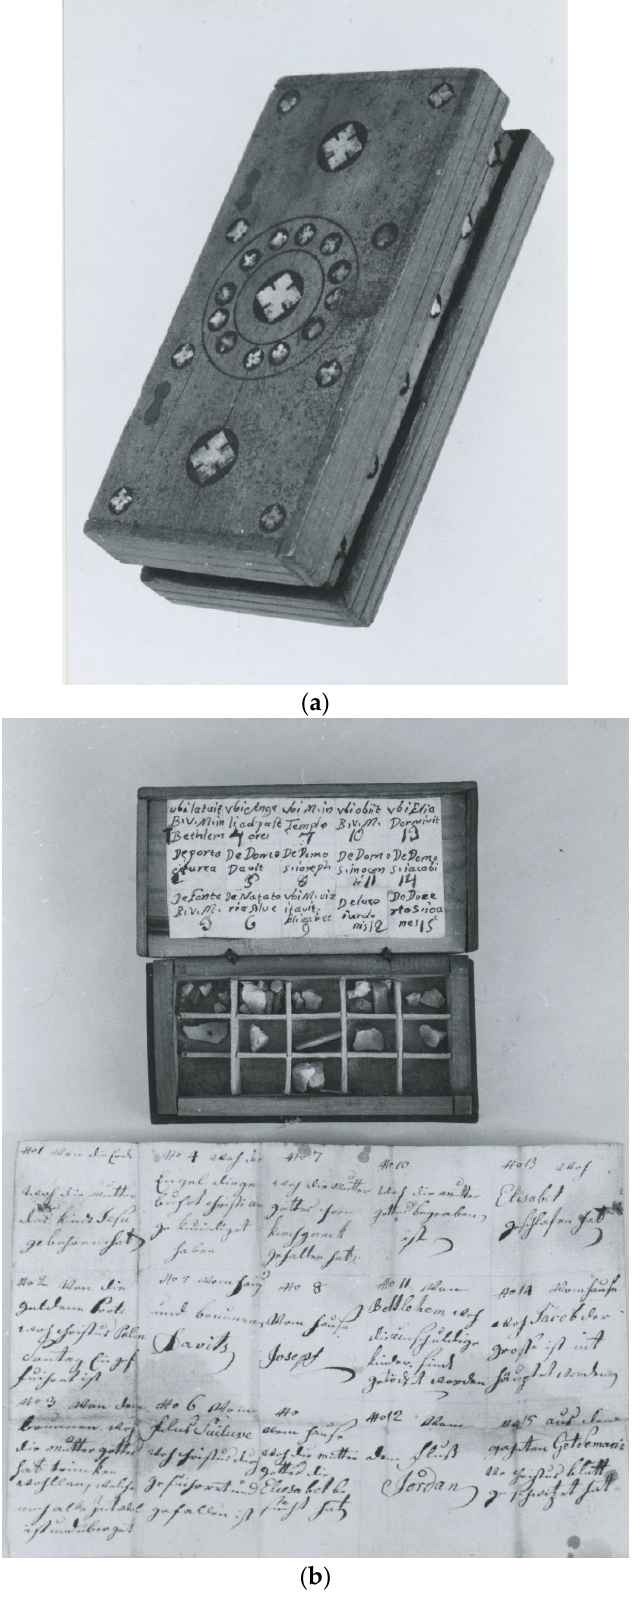
Figure 2. ( a , b ) Seventeenth-century collection (inv.no. 761) of rocks from the Holy Land accompanied by a contemporary translation of the Latin texts into German. Photo: The Danish National Museum in Copenhagen.